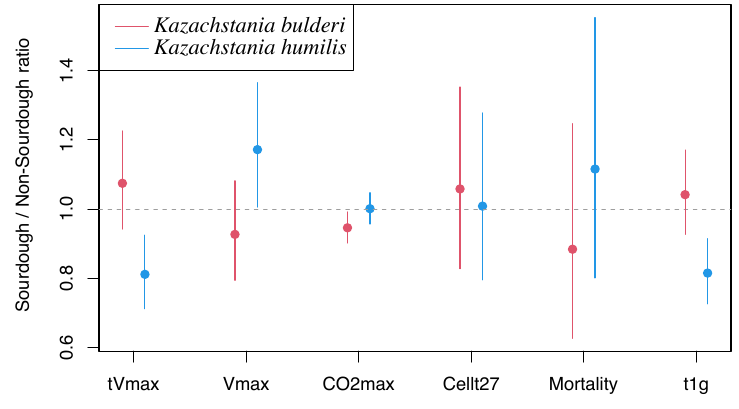
Figure 7: Ratio between the sourdough strains mean and the non-sourdough strains mean values of each quantitative variable measuring fermentation performance: time to reach the maximum production rate (tVmax), maximum CO2 production rate (Vmax), maximum CO2 production (CO2max), log of population size after 27 hours of fermentation (Cellt27), cell mortality after 27 hours of fermentation (Mortality), fermentation latency phase (t1g). Confidence intervals are indicated by bars. Mean ratio and confidence intervals are shown in red for Kazachstania bulderi and blue for Kazachtania